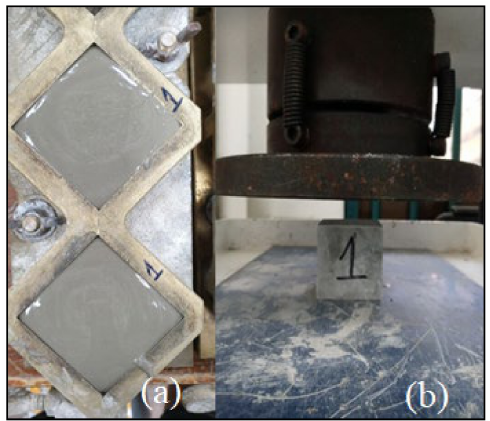
Figure 9. ( a ) Grout casting in Bronze mold and ( b ) compression test. In the second phase of testing, each grout sample was added to the aggregate in the presence of water. Grout penetration was evaluated; after solidification, the sample was placed in water for seven days for curing, because a low 28-day strength was predicted based on ASTM D6103 [13]. Special molds with a diameter of 230 mm and length of 200 mm were prepared. The aggregate was placed into the molds after compaction. The molds were filled with water, and a 65-mm-diameter pipe was inserted through the aggregate to the base of the mold for injecting the grout, as shown in Figure 10.